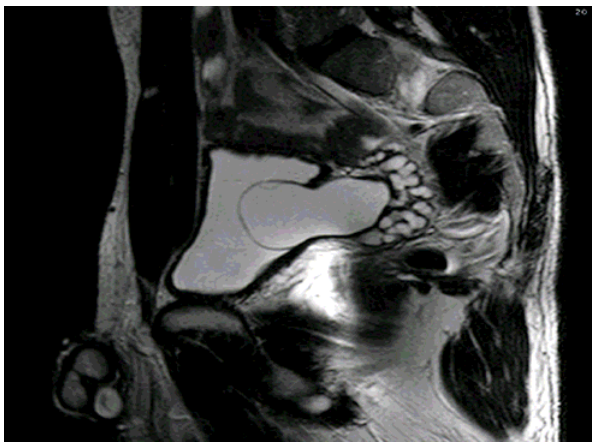
FIGURE 3 . DCE-eMRI exhibiting a